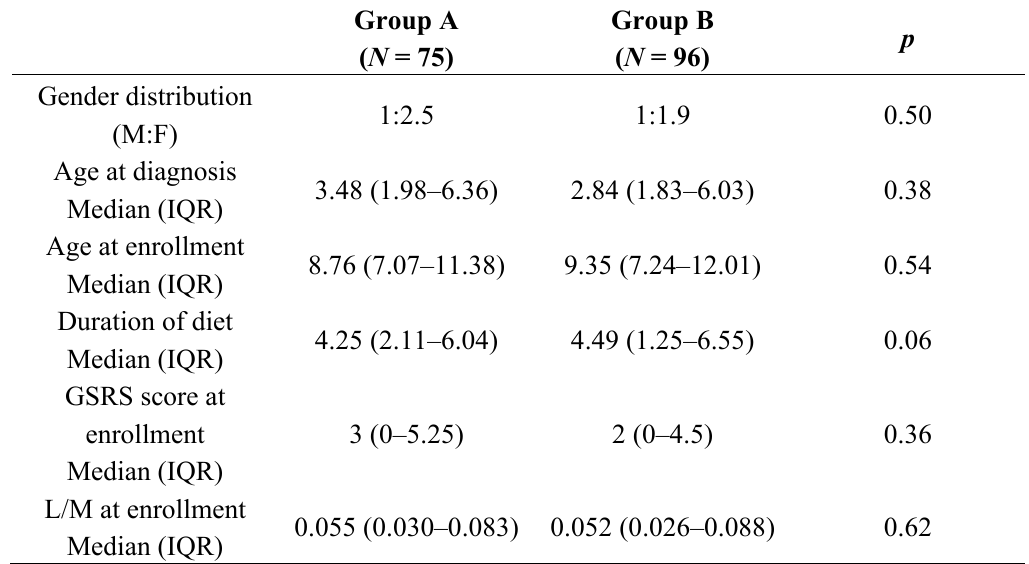
Table 1. Clinical and demographic features of children in group A and B at enrollment. M = males, F = females, IQR = interquartile